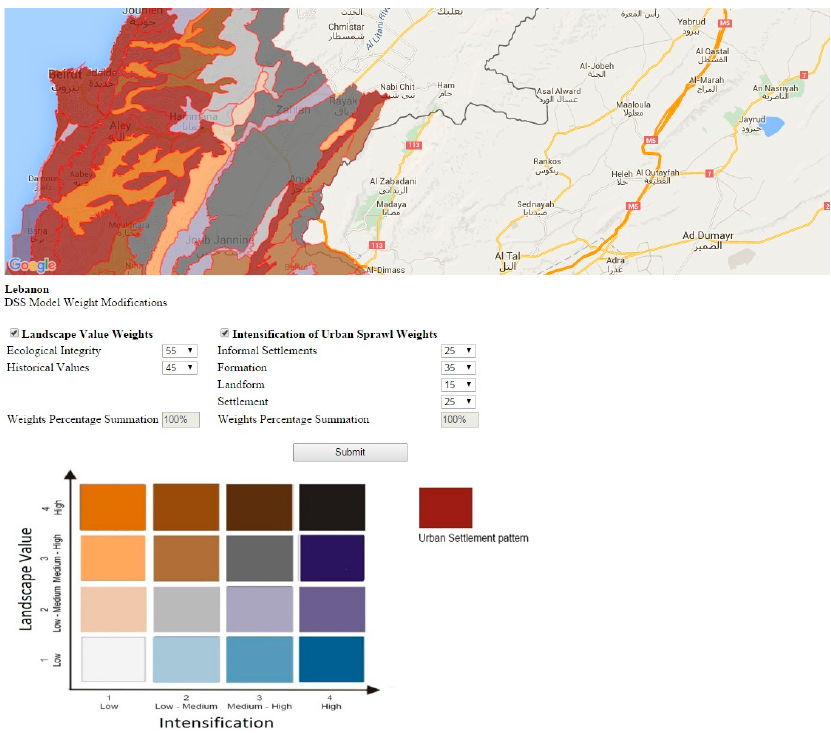
Figure 23. LDSS scenarios created by weigh modification.